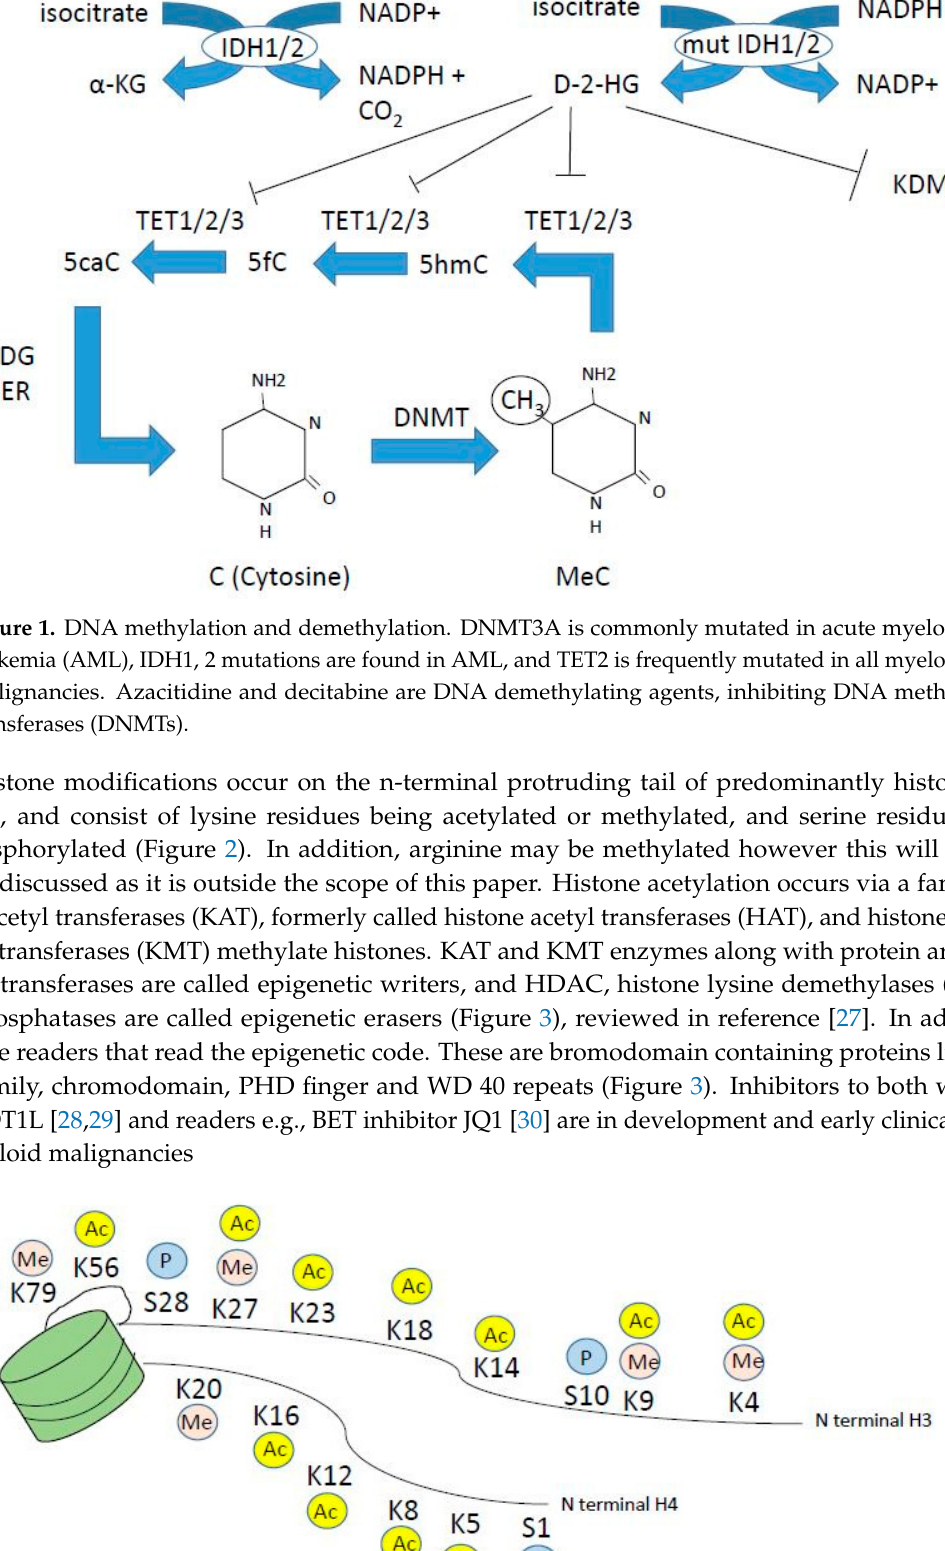
Figure 3. Epigenetic writers are histone acetyl transferases HAT (KAT), histone lysine methyl transferase (KMT) and PRMTs (protein arginine methyl transferases), readers are bromodomain proteins like BET family proteins, and erasers are histone deacetylase inhibitors (HDACi), KDM (lysine/histone demethylases) and phosphatases. Inhibitors or writers, readers and erasers are being developed and are in clinical trials for myeloid malignancies, for example HDACi, bromodomain BET inhibitor Q1 and DOT1L inhibitors, of which the latter are in clinical phase I trials. 3. Dysregulation of Histone Acetylation and Methylation in Myeloid Malignancies KATs modulate the process of hematopoiesis both via altering the epigenetic status of chromatin via histone lysine acetylation [18], and via regulation of non-histone protein acetylation [31]. Mutations in KATs, e.g., CBP and p300 have been described in myeloid malignancies, although they are rare events (Table 1, Figure 4). KAT6A (MOZ/myst3, part of the MYST family of KATs) is important in regulating hematopoietic stem cells, and is a target of translocations causing AML. Recently, Baell et al. elegantly showed that KAT6A/B (MOZ/myst 3 and myst 4) inhibitors arrest tumor growth and induce senescence in AML cells, in vitro and in vivo [32]. UTX (KDM6A) acetylates H3K27ac thus mediating active chromatin, and UTX mutations are found in AML (Table 1) [33].